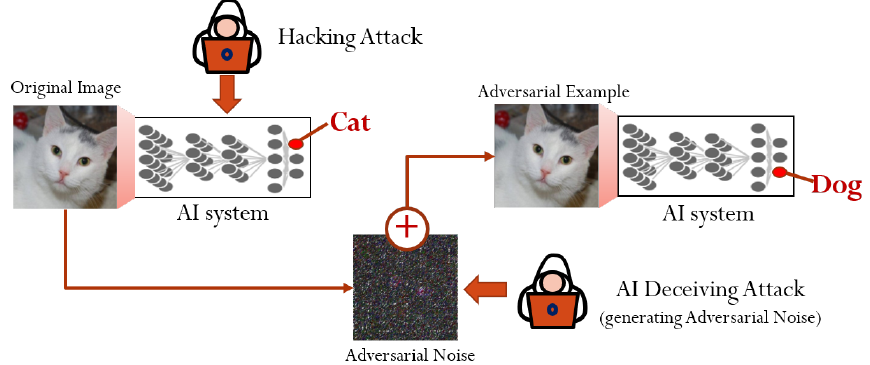
Figure 1. Concept of artificial intelligence (AI) deceiving attack. A small adversarial noise added to the original image can make the neural network to classify the image as a Guacamole instead of an Egyptian cat. This is in contrast to a hacking attack that intrudes the system through an abnormal